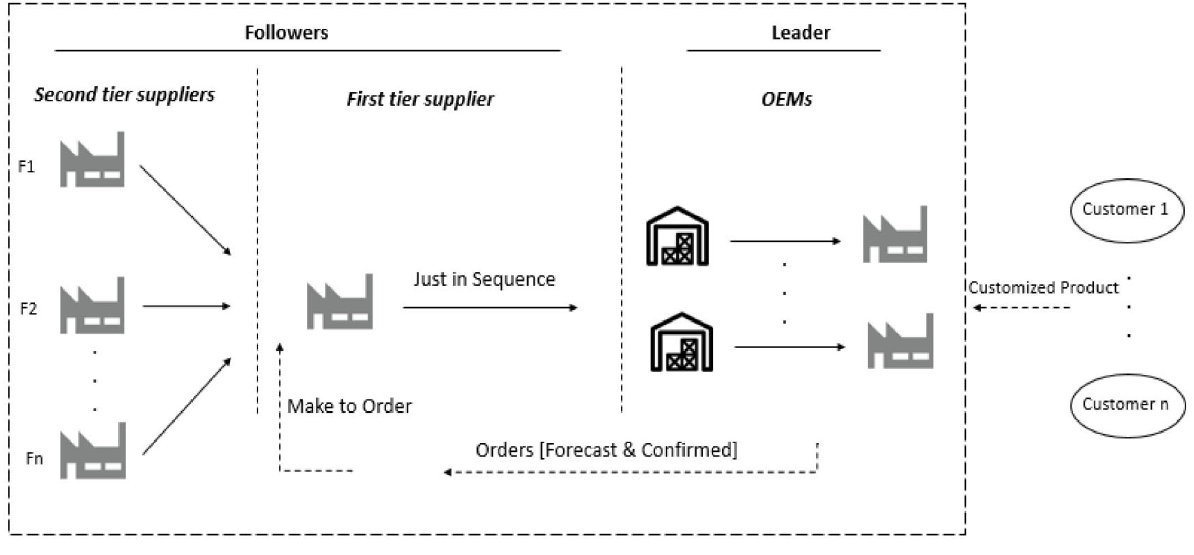
Figure 1. Supply chain